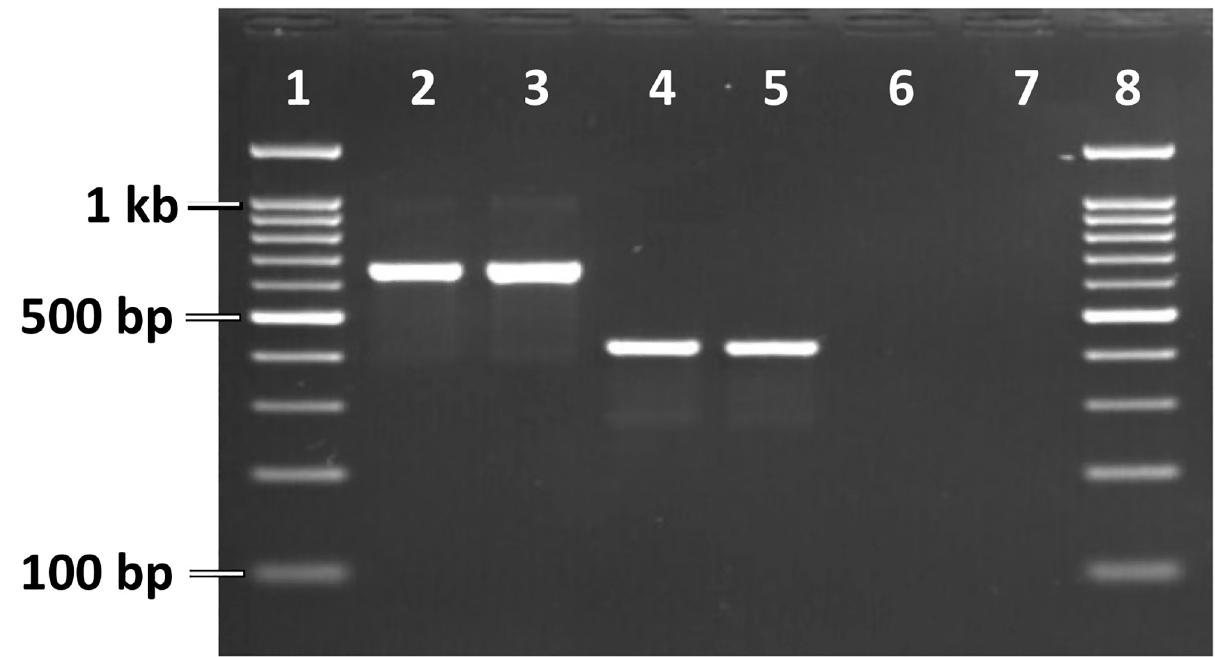
Fig 1. PCR assay for the identification of molecular forms of An . subpictus . Lanes 1 and 8: 100 bp ladder; lanes 2–3: Form A; Lanes 4–5: Form B; lanes 6: An . vagus ; lane 7: negative control, without DNA.